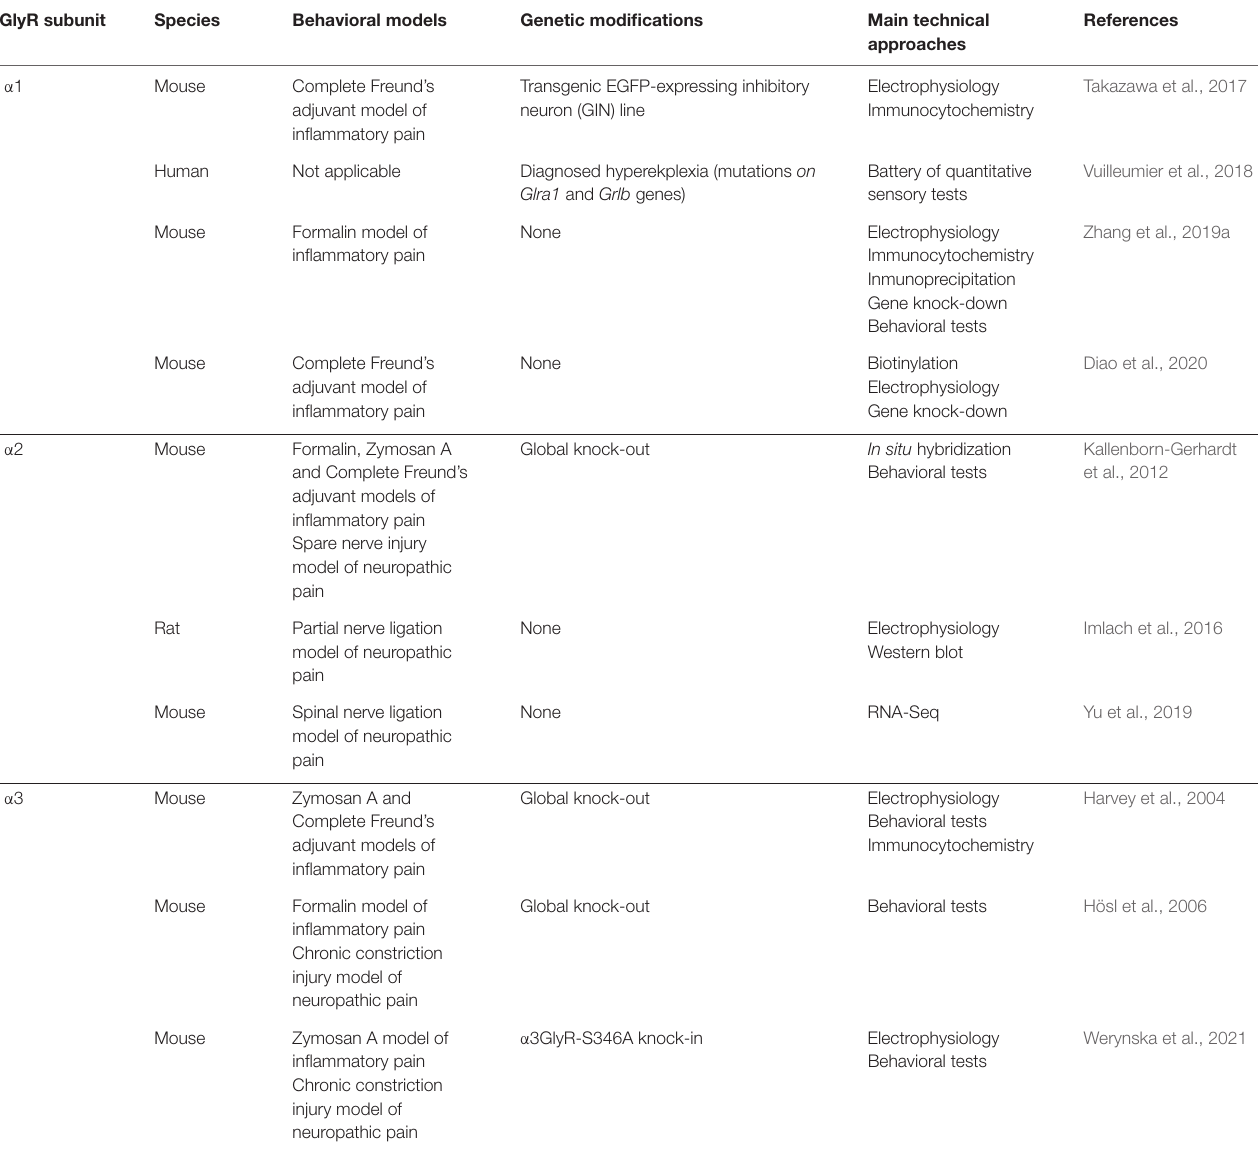
TABLE 1 | Participation of GlyR α subunits in nociception and chronic pain